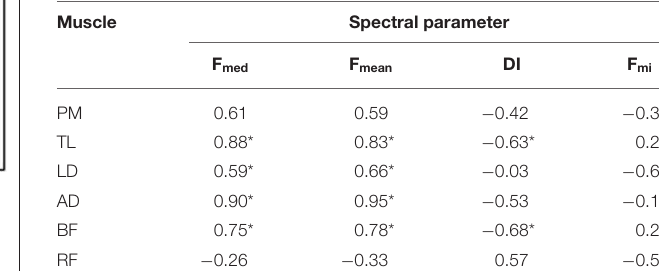
TABLE 1 | Pearson correlation coefficient r Pearson coefficients between normalized variations of spectral parameters (electrophysiological fatigue) and normalized variations of torque (mechanical